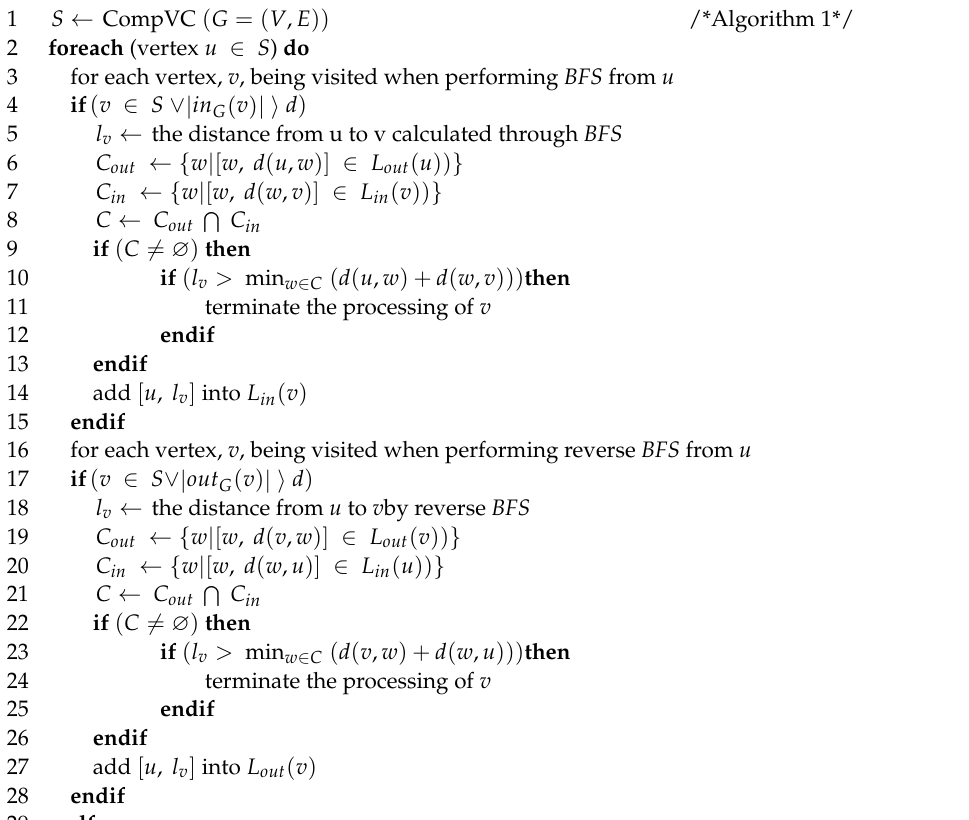
Algorithm 4 genVCIndex + ( G = ( V , E ) , d